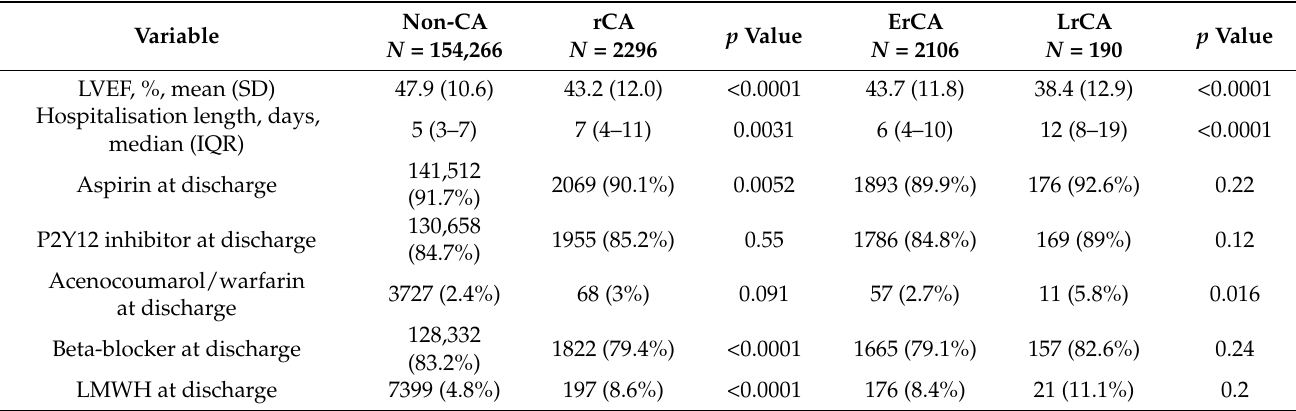
Table 4. Discharge data of patients without cardiac arrest and with ErCA and LrCA after acute myocardial infarction (only patients who were discharged after index